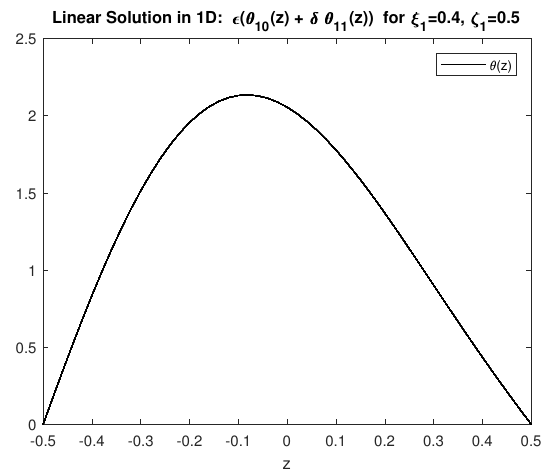
Figure 7. Linear 1D solution for θ , i.e., (cid:101) ( θ 10 ( z ) + δθ 11 ( z )) .